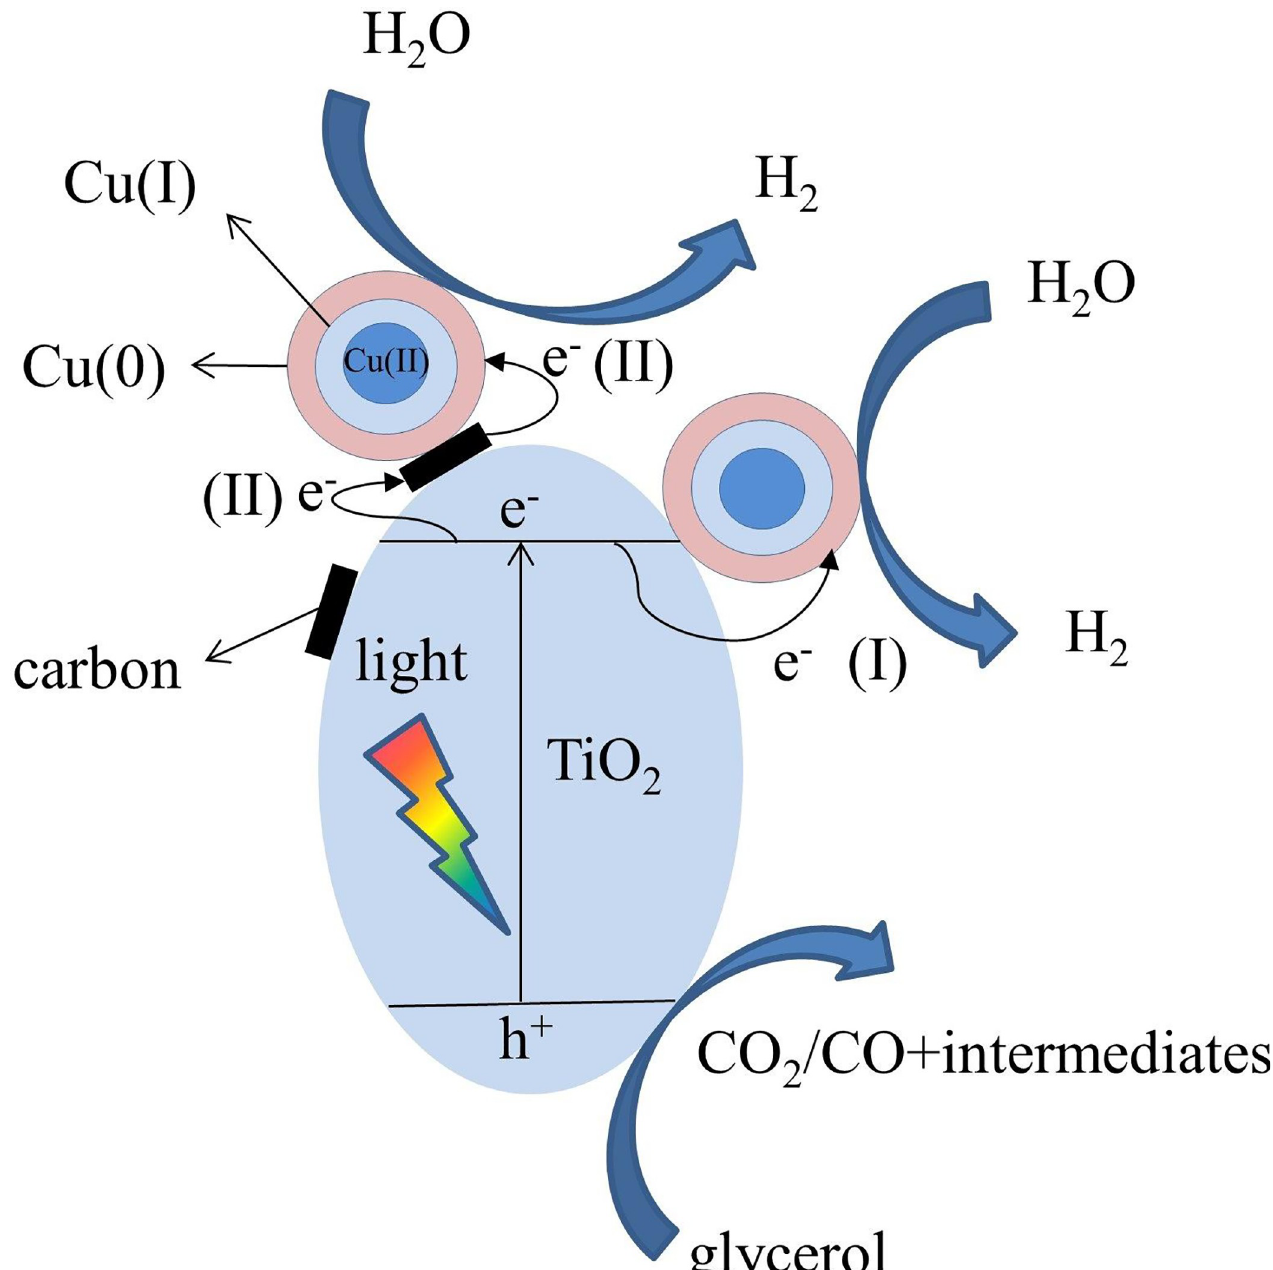
Fig 11. Photocatalytic hydrogen evolution mechanism of the CuO x -C/TiO 2 catalyst with direct (I) and indirect (II) electron transport pathways. https://doi.org/10.1371/journal.pone.0215339.g011 species to form Cu(I) or Cu(0), which results in efficient electron-hole separation (Eq 3). Meanwhile, CuO species can act as proton reduction reaction sites for hydrogen generation x